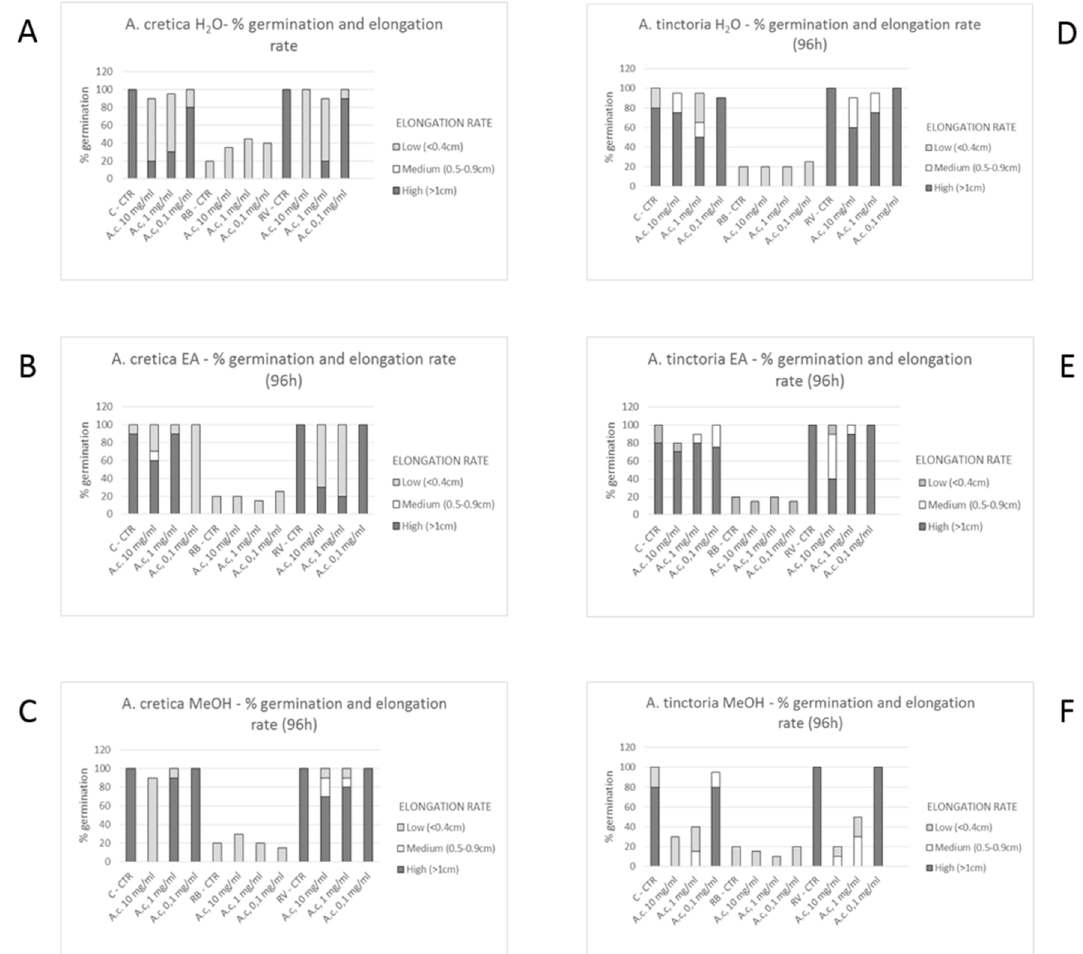
Figure 3. Seedling germination and growth of Canasta (C), Romana verde (RV) and Romana bionda (RB) seeds challenged with A. tinctoria and A. Cretica extracts. Results are expressed as root and hypocotyl (seedling) length ± SD at different concentrations and mean of GP after the fourth day since the sowing. ( A ): Effect of A. cretica water extract on seedling germination. ( B ): Effect of A. cretica ethyl acetate (EA) extract on seedling germination. ( C ): Effect of A. cretica water methanol (MeOH) on seedling germination. ( D ): Effect of A. tinctoria water extract on seedling germination. ( E ): Effect of A. tinctoria ethyl acetate (EA) extract on seedling germination. ( F ): Effect of A. tinctoria water methanol (MeOH) on seedling germination.